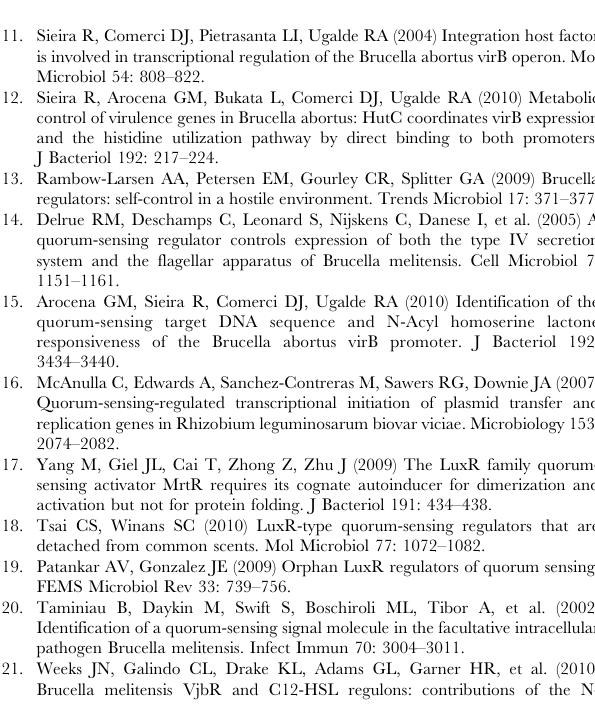
Figure S1 Effect of pH on bacterial viability in MM1. (A) Wild-type strain B. abortus 2308 was grown in TSB until OD 600 , 1.5. Subsequently, cultures were centrifuged and bacteria were resuspended in medium MM1 at pH 4.5, 5.5, or 7.0; in the absence (open bars) or in the presence (gray bars) of 5 mM urocanic acid. After 4 h of incubation, OD 600 was measured and CFU/ml was determined by serial dilution and plating on TSB agar for bacteria incubated at the indicated pH values. Values are means 6 standard deviations of duplicate samples from a representative of two independent experiments. (B) Effect of pH 4.5 on bacterial viability at different times. Wild-type strain B. abortus 2308 was grown in TSB until OD 600 , 1.5 and shifted to MM1 at pH 4.5 in the absence (open circles) or in the presence (gray circles) of 5 mM urocanic acid. At the indicated times, OD 600 was measured and CFU/ml was determined by serial dilution and plating on TSB agar. Values are means 6 standard deviations of duplicate samples from a representative of two independent experiments. **, P , 0.01; *, P , 0.05.